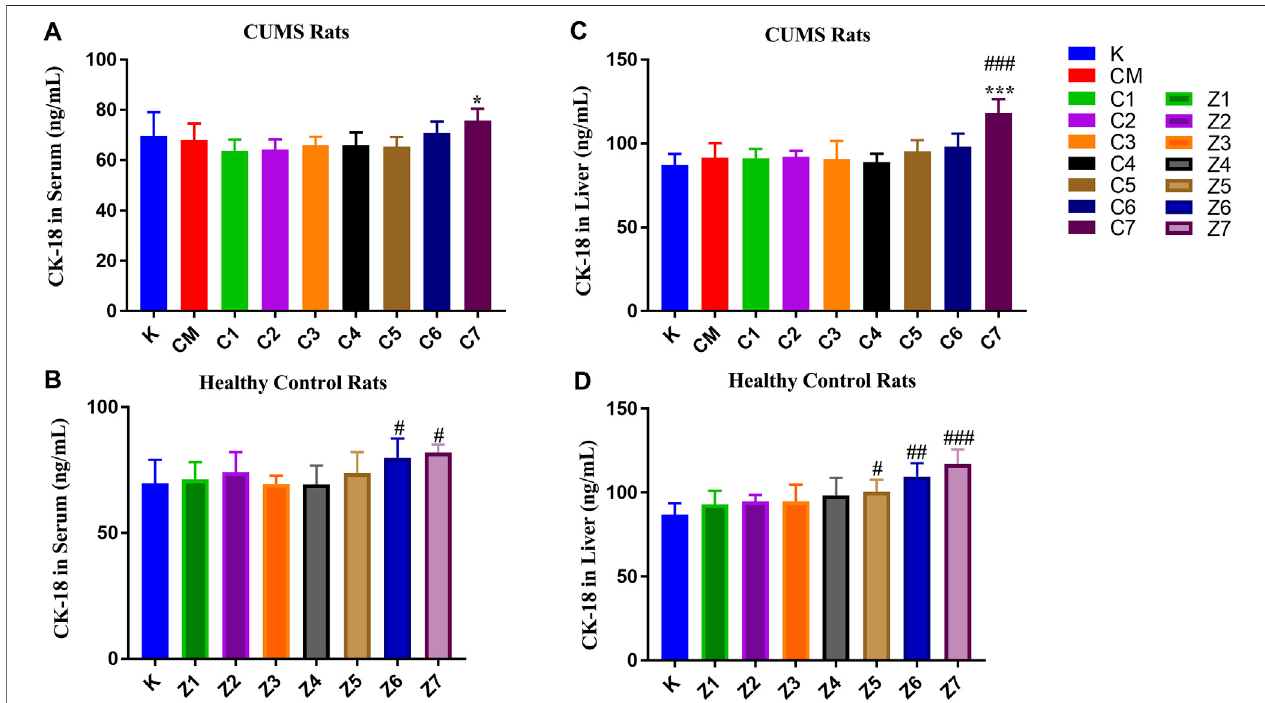
FIGURE 2 | CK-18F level in serum samples of CUMS rats (A) and control rats (B) administration with PBR. CK-18F level in liver samples of CUMS rats (C) and control rats (D) administration with PBR. [CM] CUMS rats, [K] control rats, [C1] ∼ [C7] CUMS rats given PBR (7 different dosages), [Z1] ∼ [Z7] control rats administered PBR, and [CY] CUMS rats administered venlafaxine hydrochloride. Data represent the mean ± SD of each group. #, compared with the K group (# p < 0.05, ## p < 0.01, ### p < 0.001); *, compared with the CM group (* p < 0.05, *** p <